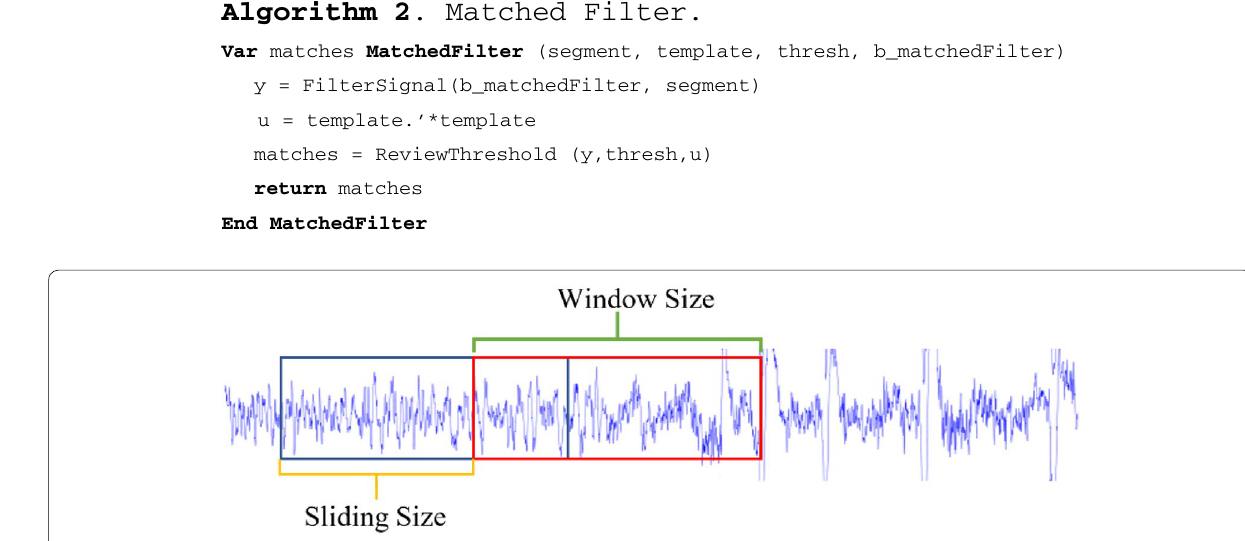
Fig. 3 Analysis scheme by window